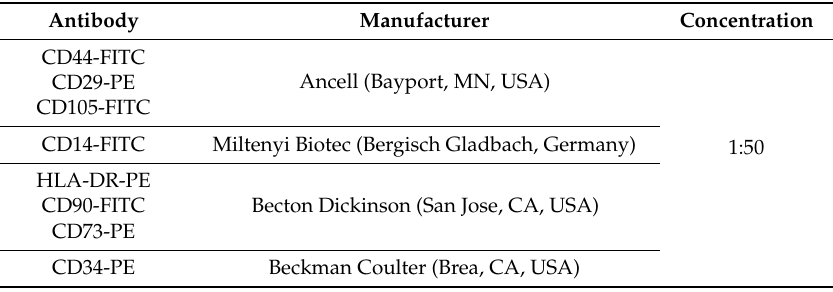
Table 3. Antibodies and concentrations used for cell